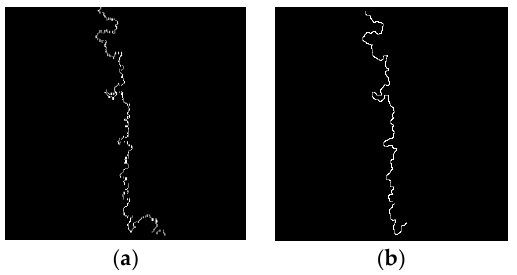
Figure 13. Edge results comparing different morphological processing: ( a ) basic morphology; ( b ) improved anti-noise morphology.